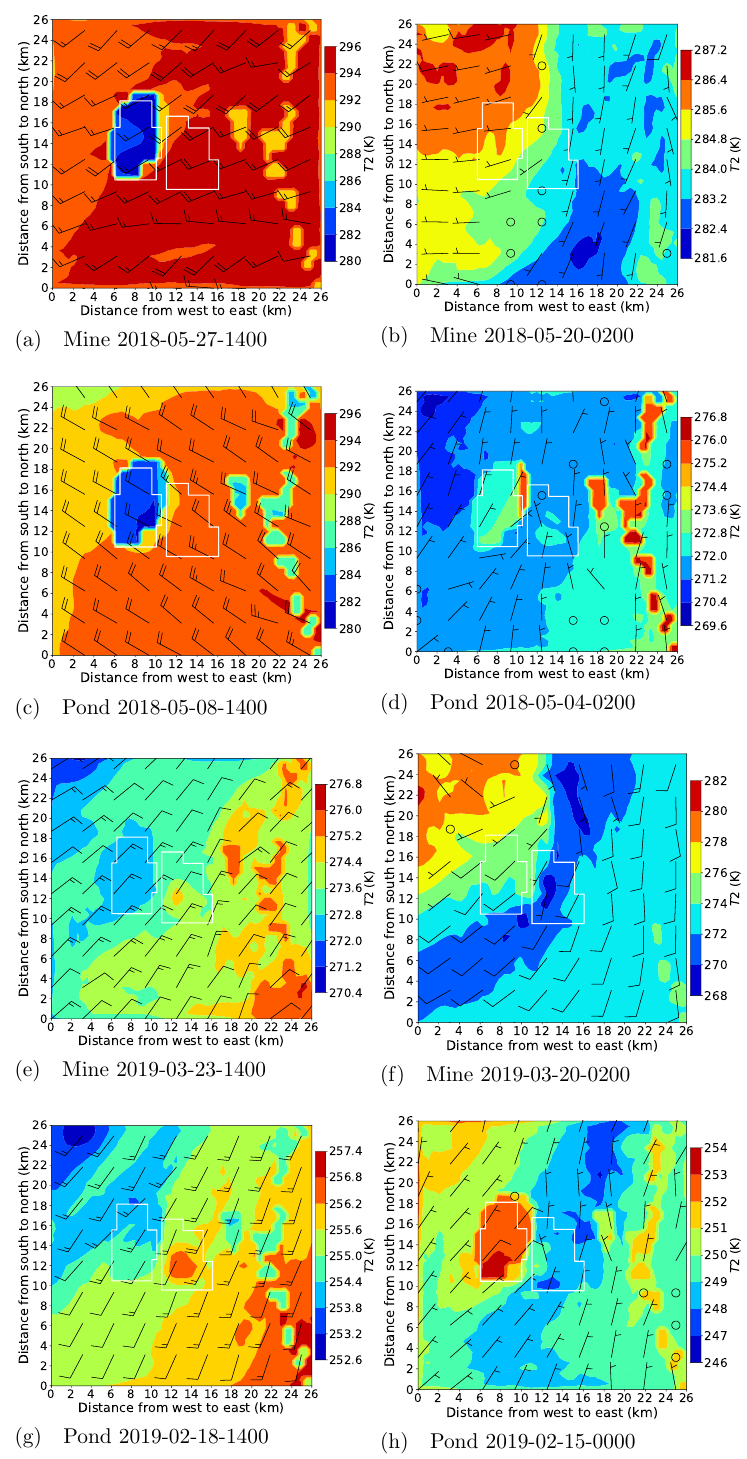
Figure 6. Wind barbs at 10 m and temperature contour at 2 m; the white lines show the perimeter of area sources for methane mixing ratio boundary condition for the mine and pond; times in local standard time (LST = UTC − 7); ( a ) Mine 2018-05-27-1400; ( b ) Mine 2018-05-20-0200; ( c ) Pond 2018-05-08-1400; ( d ) Pond 2018-05-04-0200; ( e ) Mine 2019-03-23-1400; ( f ) Mine 2019-03-20-0200; ( g ) Pond 2019-02-18-1400; ( h ) Pond